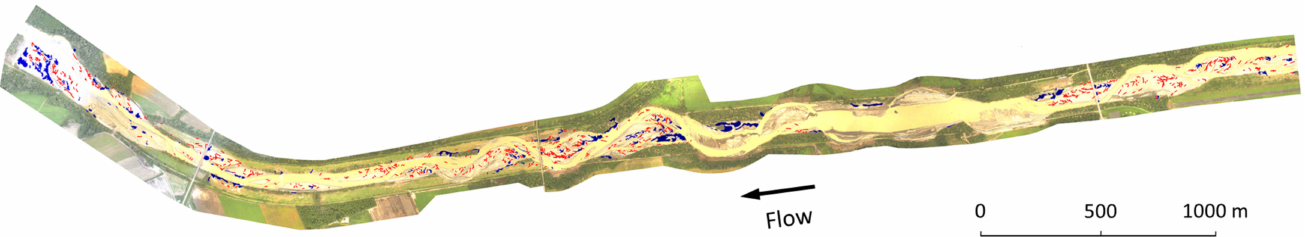
Figure 1. Driftwood deposition observed after large flood event in Otofuke River, Japan. Red color indicates single pieces, and blue denotes formation of logjams following driftwood deposition. (Courtesy of Hokkaisuiko Consultant